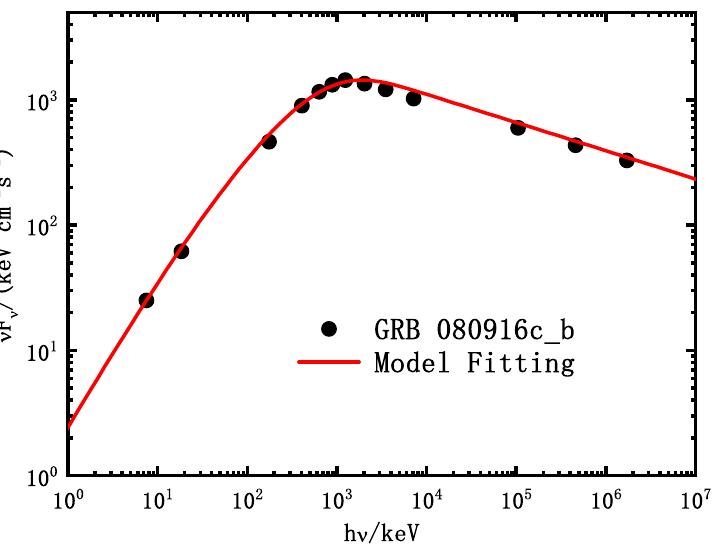
Figure 5. The time-averaged spectrum to fit the interval “b” of GRB 080916c. The black points are selected from the Band function with the low-energy photon index α = − 1.02 ± 0.02, the high-energy photon index β = − 2.21 ± 0.03 and the peak energy E p = 1170 ± 140keV provided in Ref. [43], which are precise enough to present the tendency of the actual GRB emission. This spectral duration is from 3.58 s to 7.68 s and we fit it by adopting the time-averaged spectrum from t = 0 s to t = 3 s ( t max ≤ t crs ). The fitting parameters are listed in Table